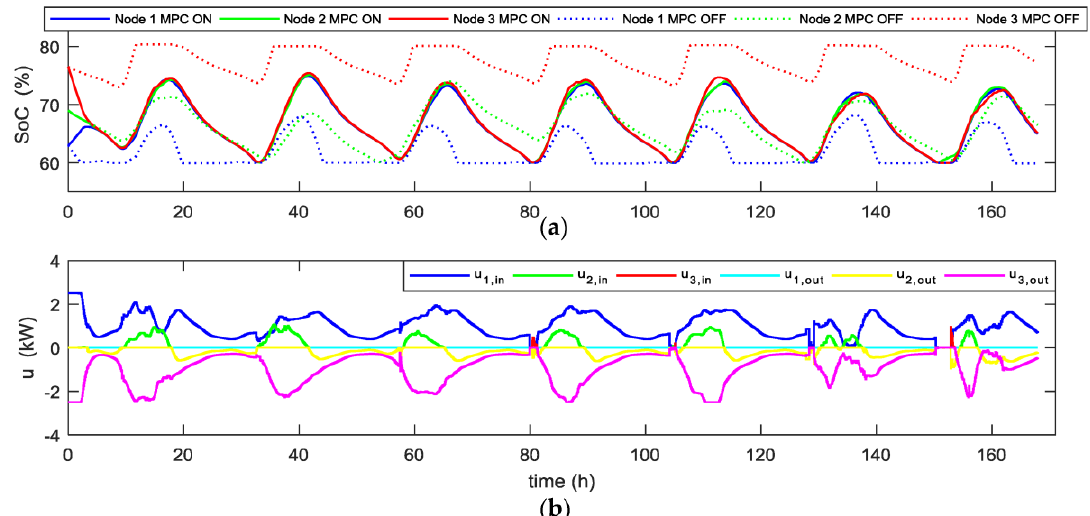
Figure 20. ( a ) Battery SOC at each node with NMPC enabled; ( b ) Control actions u applied at each time step at the DC/DC converters.